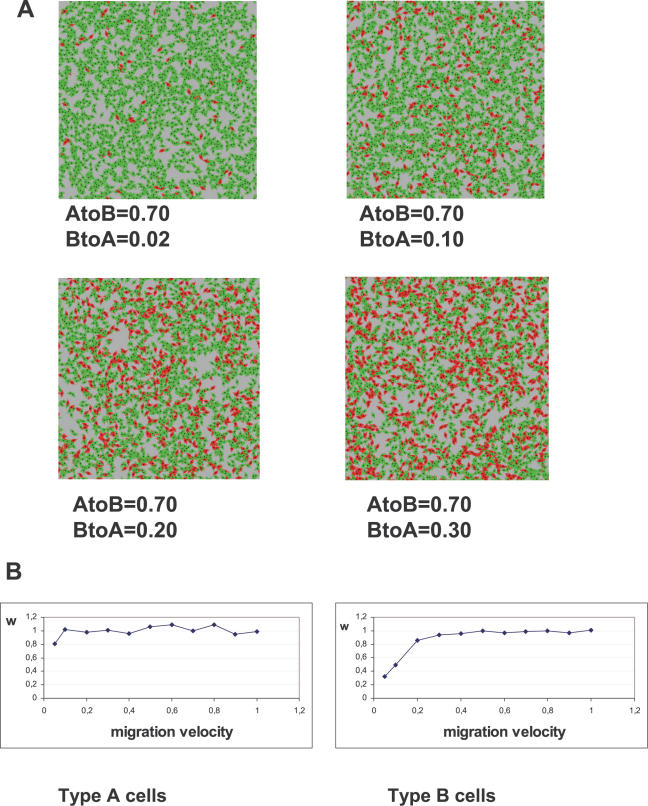
The “intrinsic” model.
A: Results of the “intrinsic” model simulations for large values for pBtoA. Note corresponding increase in proportion of type A cells (in red) and their random distribution. B: Analysis of type A (left panel) and type B (right panel) cell distributions in the “intrinsic” model as a function of average migration velocity using the standardized nearest neighbour distance (w). If w = 1, the cells are randomly distributed. Small standardized nearest neighbour distances (w<1) indicate clustering; this is only observed for B cells with very low average migration velocities (<0.2). In these examples pAtoB = 0.7 and pBtoA = 0.02, but similar results were obtained for other values of p.